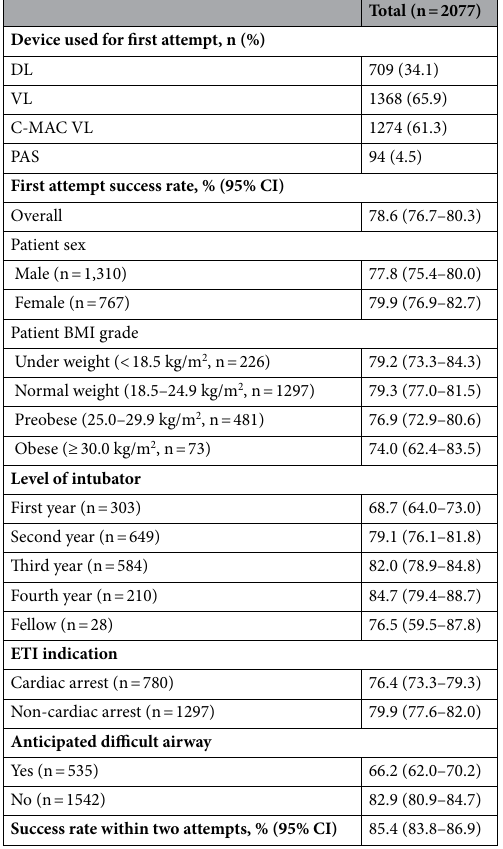
Table 2. Device used for first attempt and ETI success rate. ETI endotracheal intubation, DL direct laryngoscope, VL video laryngoscope, PAS Pentax Airwayscope, CI confidence interval, BMI body mass index.